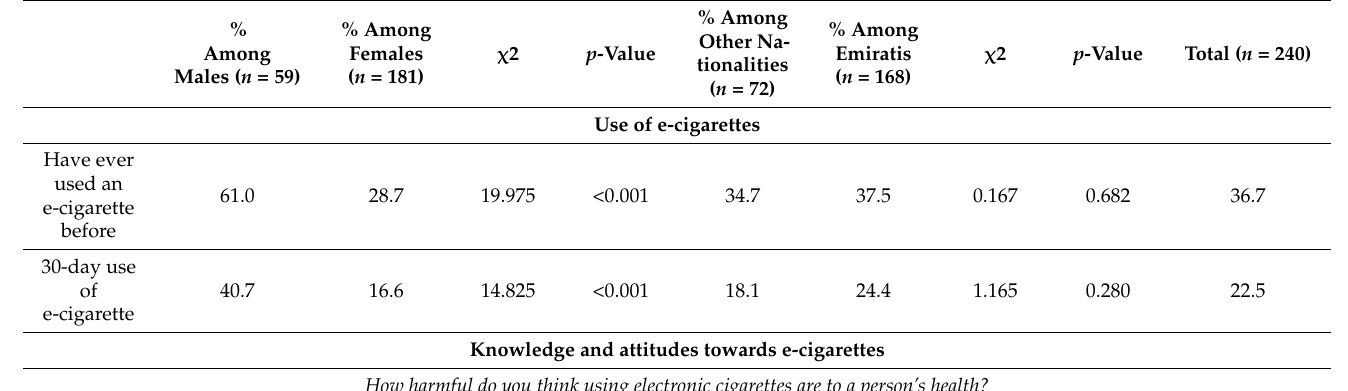
Table 2. Patterns of use and knowledge about e-cigarettes across gender and